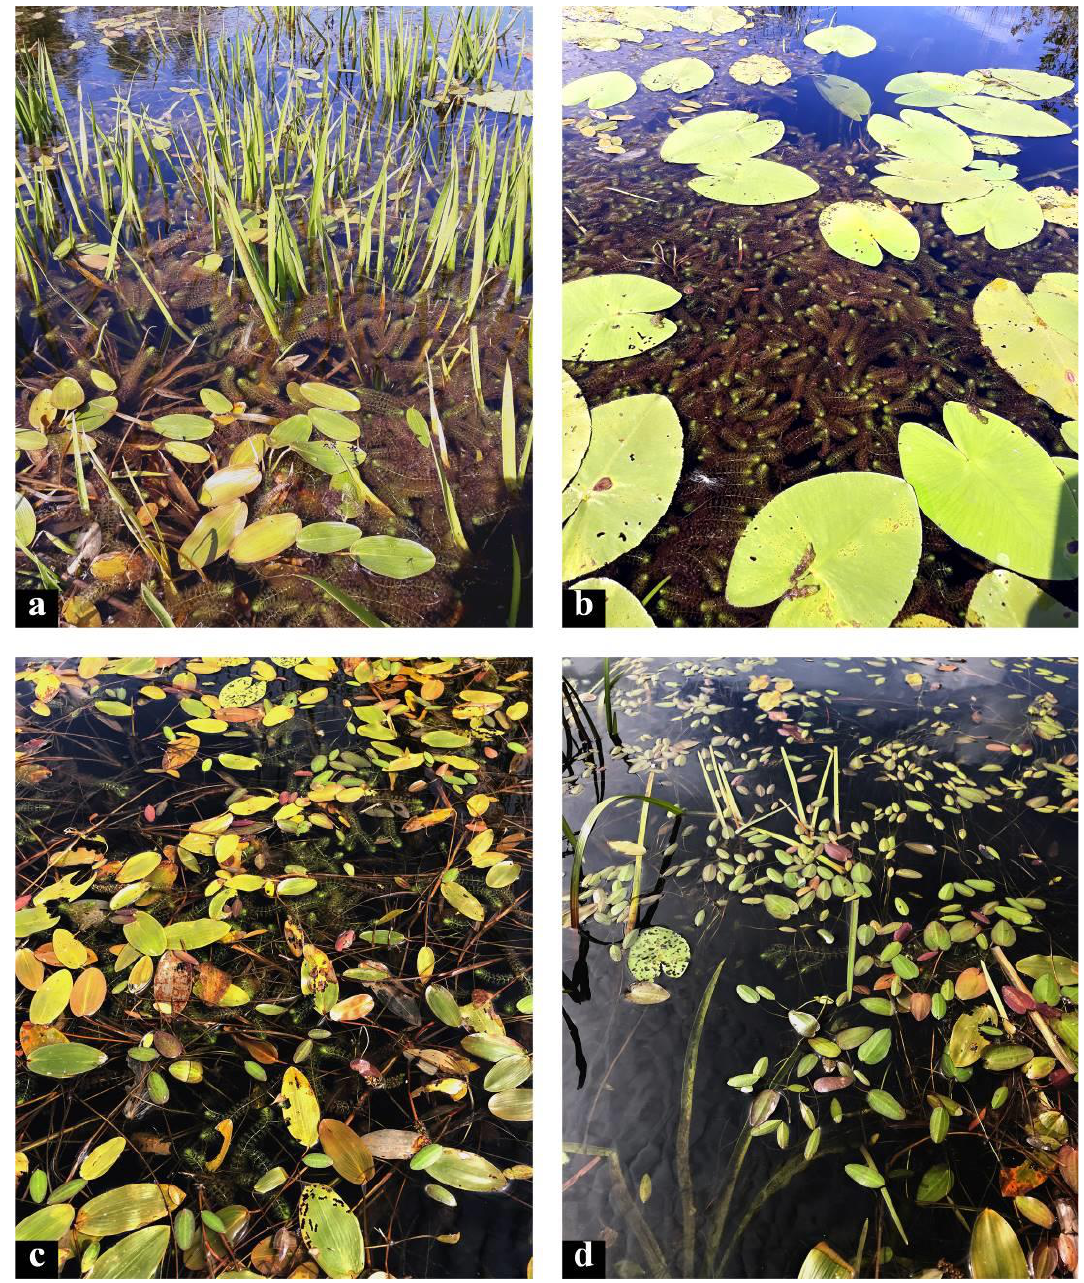
Figure 3. Plant communities of floating-leaved and floating plants with dominant Aldrovanda vesiculosa ( a , b ) and communities with Aldrovanda vesiculosa and Caldesia parnassifolia ( c , d ) in Lake Rūžas. Photos by Z. Sinkevičienė ( a , b ) and L. Petrulaitis ( c , d ).